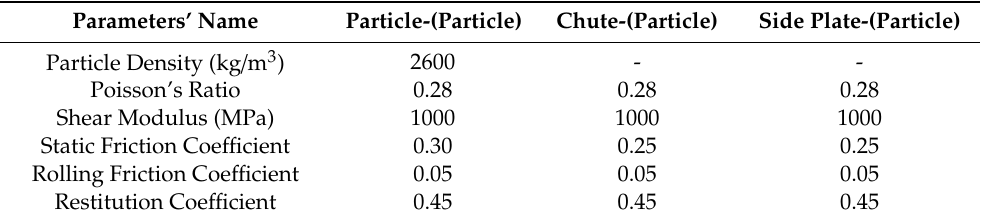
Table 1. Material parameters used in the numerical experiments.